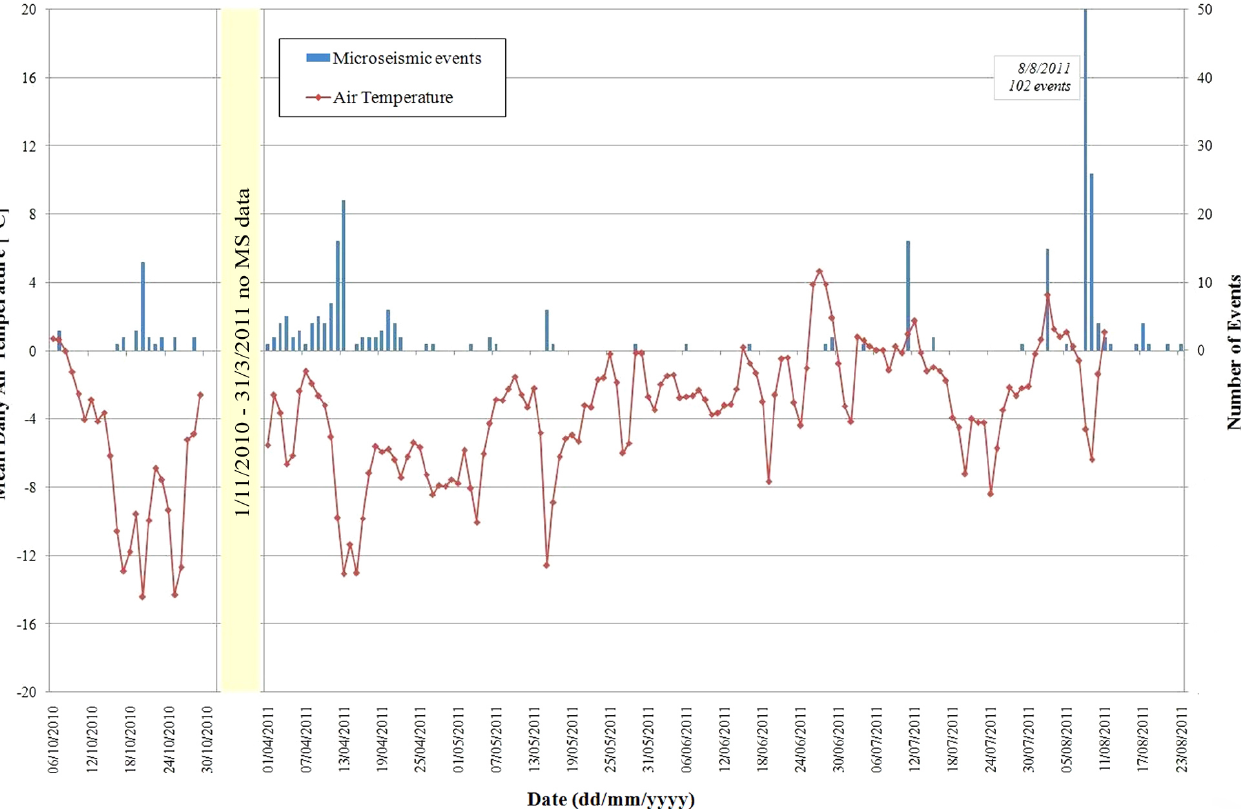
Fig. 12. Correlation between MS activity and temperature variations: continuous dot line represents the mean daily air temperature recorded close to the J. A. Carrel hut, on the North-West side of the ridge; histogram represents daily number of